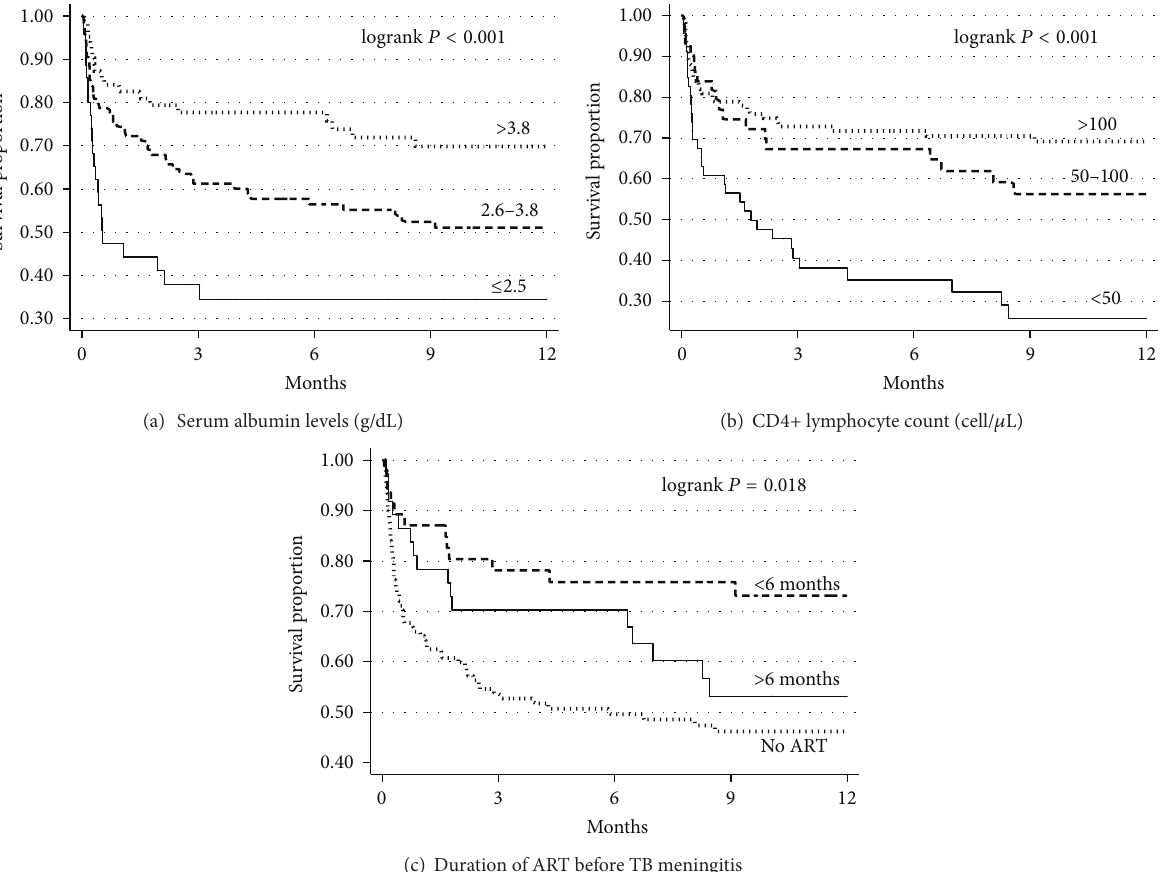
Figure 2: Kaplan-Meier survival estimates by baseline serum albumin levels (a), CD4 lymphocyte count (b), and duration of antiretroviral therapy (ART) of 203 HIV patients with tuberculous meningitis (c). ART, antiretroviral therapy; TB, tuberculous.